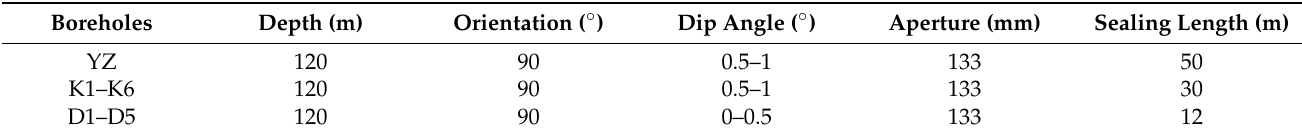
Figure 4. Schematic diagram of test borehole layout. Table 3. Drilling design parameter table of L-CO 2 injection